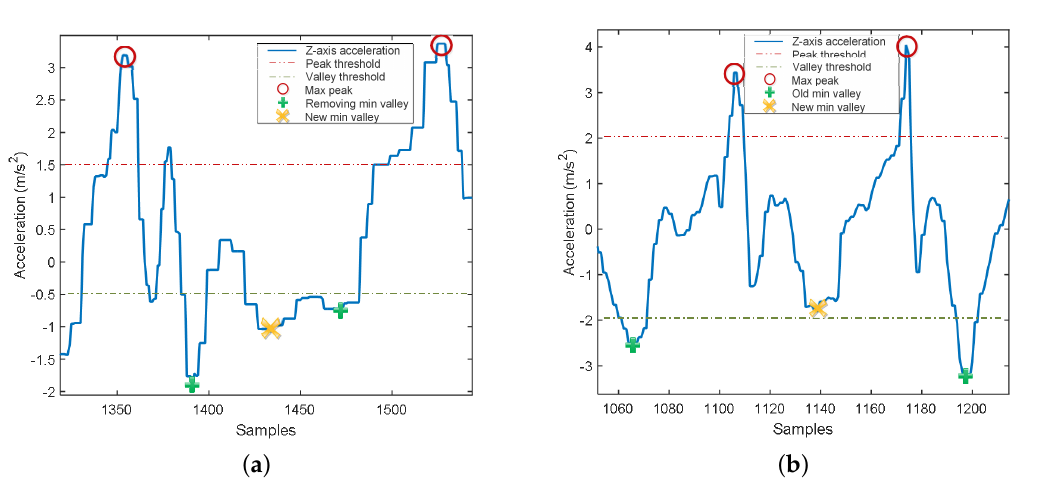
Figure 6. Unexpected minima-set solution in specific cases: ( a ) No maximum; ( b ) Two